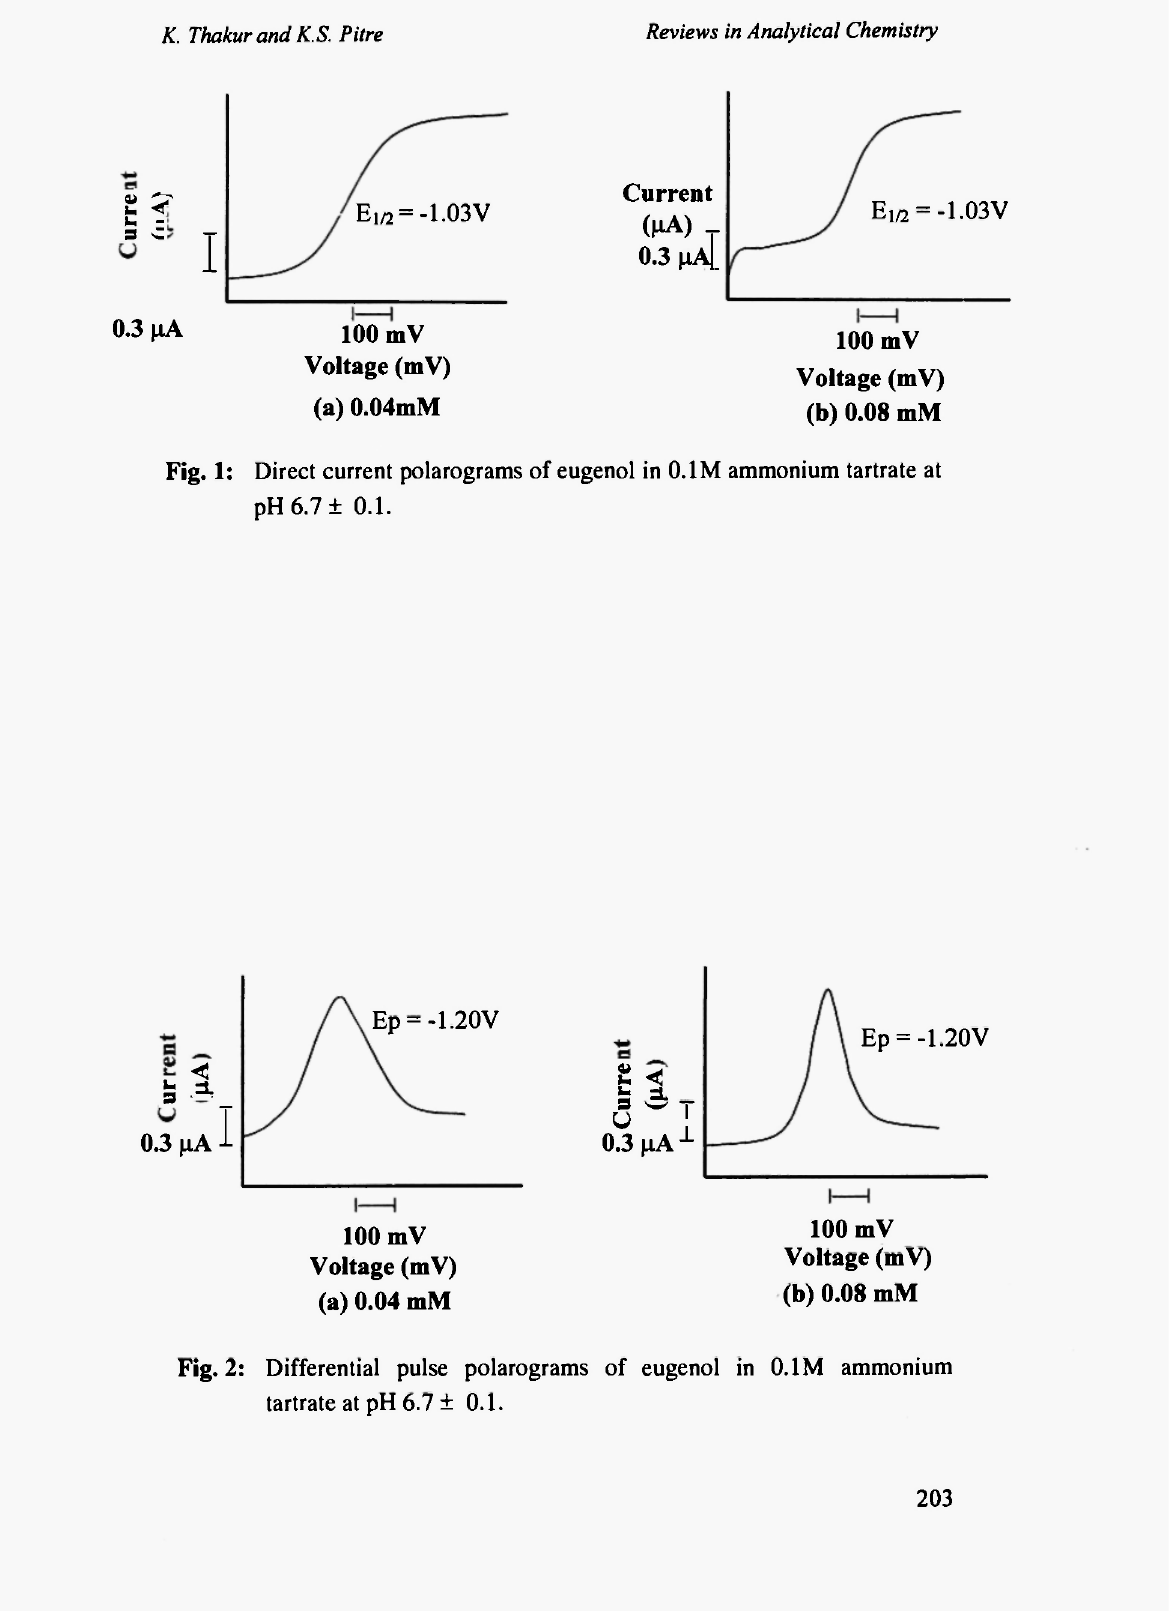
Fig. 2: Differential pulse polarograms of eugenol in 0.1M ammonium tartrate at pH 6.7 ±